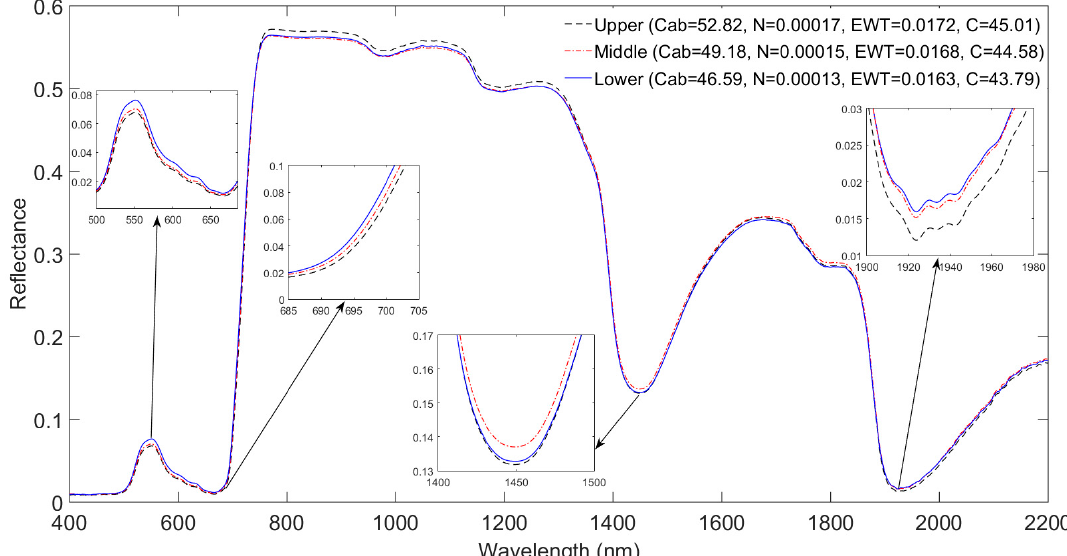
Figure 2. Mean leaf spectral reflectance at each canopy position for the pooled dataset. Note that the red edge shifts to longer wavelengths with increasing C ab .